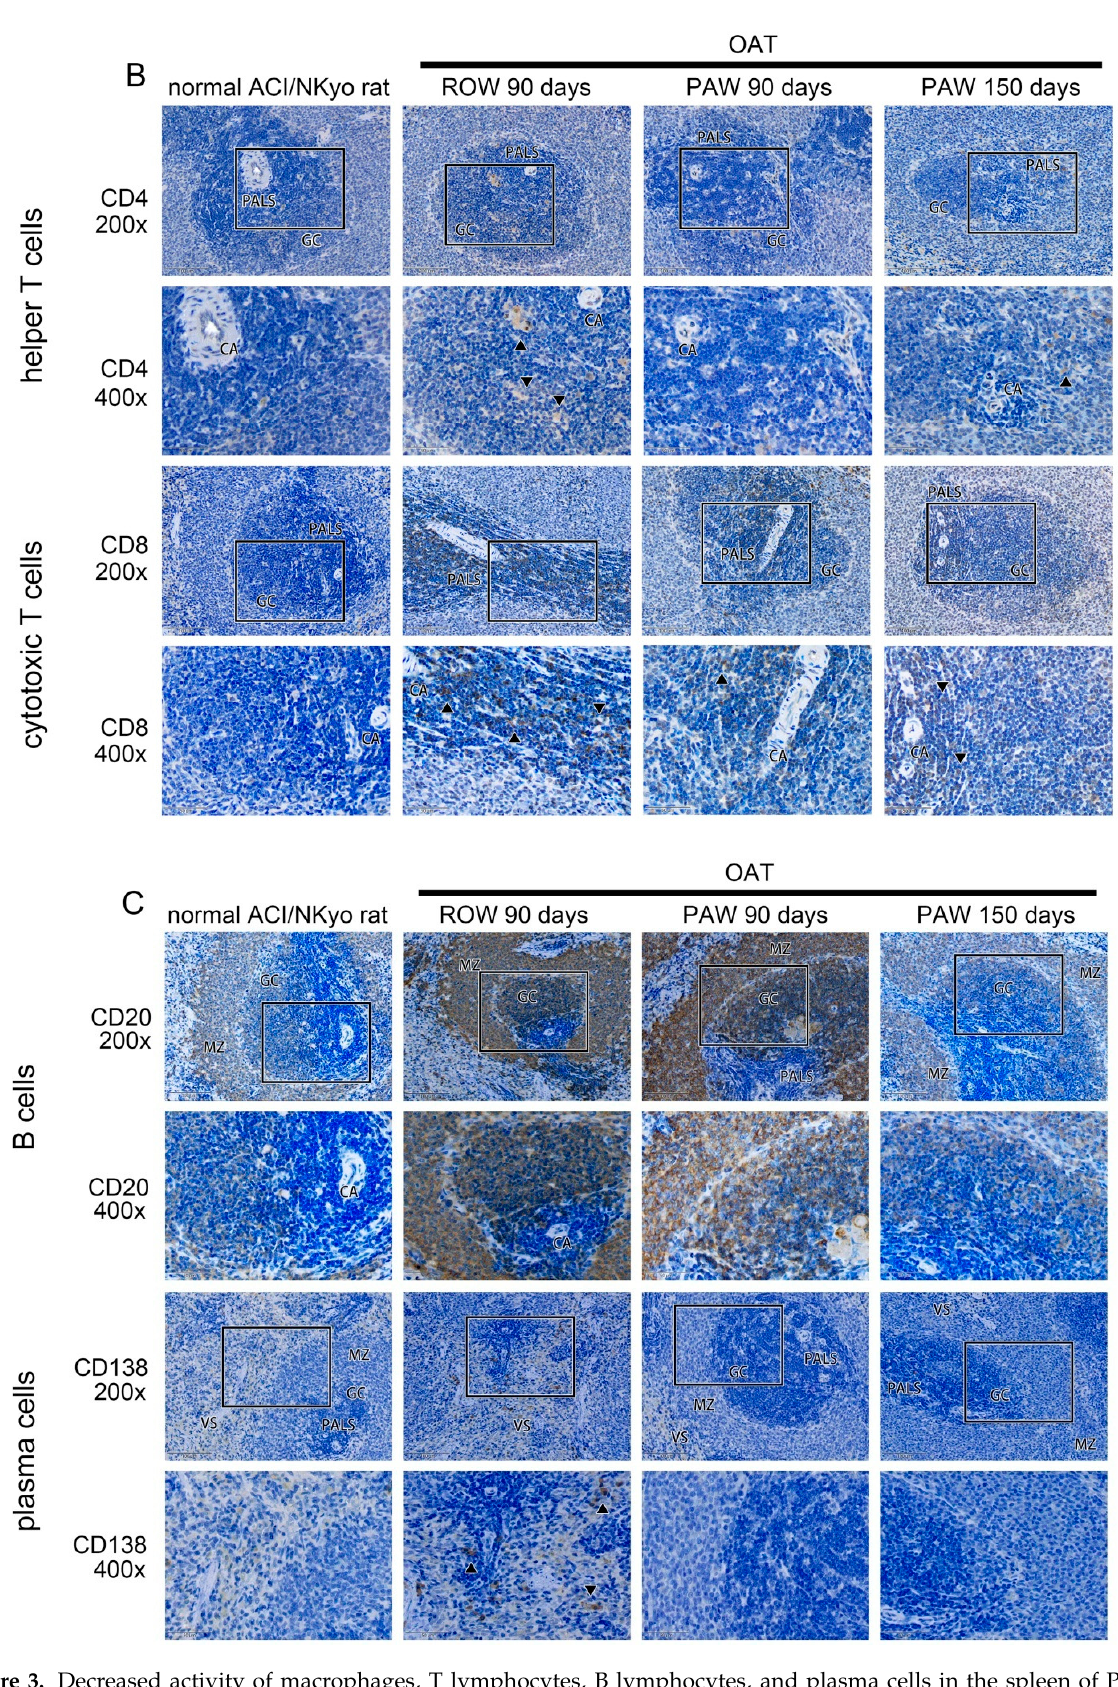
Figure 3. Decreased activity of macrophages, T lymphocytes, B lymphocytes, and plasma cells in the spleen of PAW administered OAT-ACI/NKyo rats. ( A ) Immunohistochemistry was performed to assess the accumulated macrophages